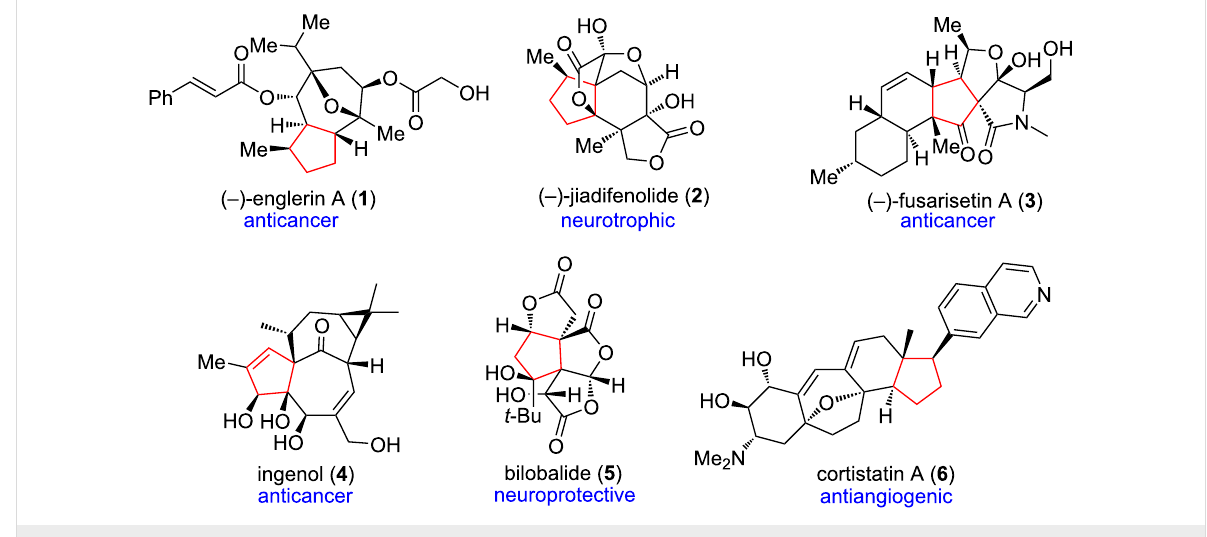
Figure 1: Highly-substituted five-membered carbocycle in biologically significant natural products.